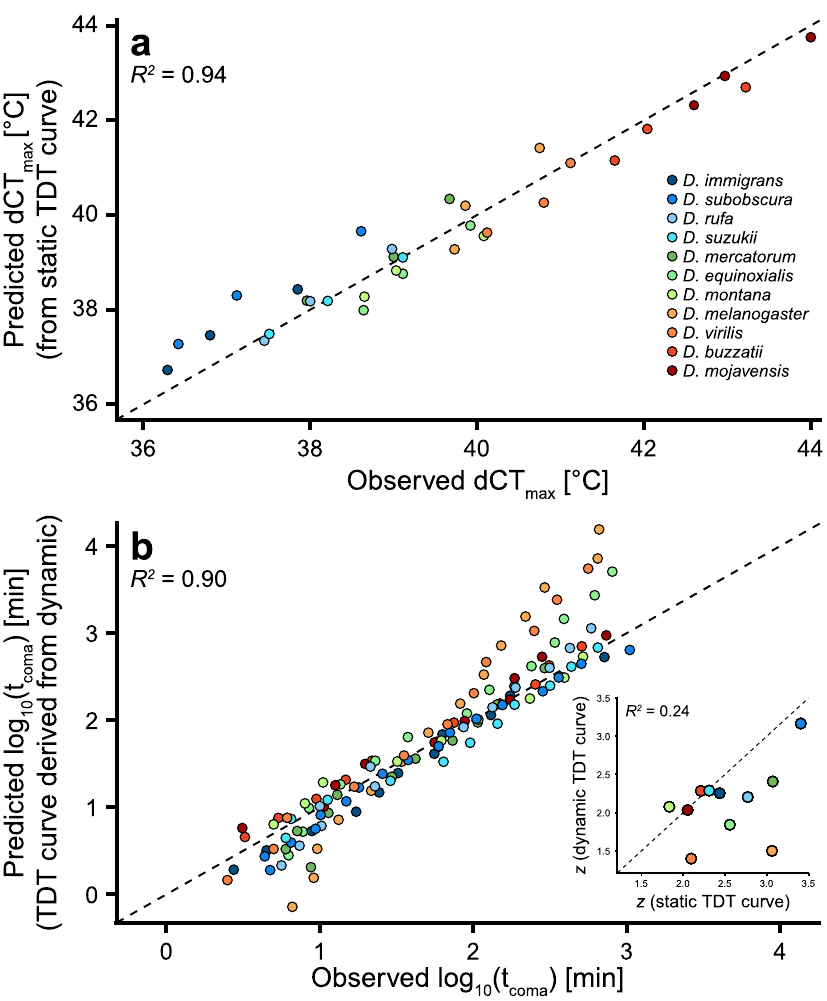
Figure 6. Conversion of heat tolerance measures between static and dynamic assays in Drosophila . Data from 43 . ( A ) Heat tolerance (dCT max , d for dynamic assays) plotted against predicted dCT max derived from species- specific TDT curves created from multiple (9–17) static assays. Data are presented for three different ramping rates (0.05, 0.1 and 0.25 °C min -1 ). Note that this graph is adapted from Fig. 4b in 15 . ( B ) TDT parameters based on dCT max from three dynamic tests were used to predict t coma in static assays. Each point represents an observed vs. predicted value of species- and temperature-specific log 10 (t coma ). (Inset) Species values of the thermal sensitivity parameter z parameterized from TDT curves based on static assays (x-axis) or dynamic assays (y-axis). The dashed line represents the line of unity in all three